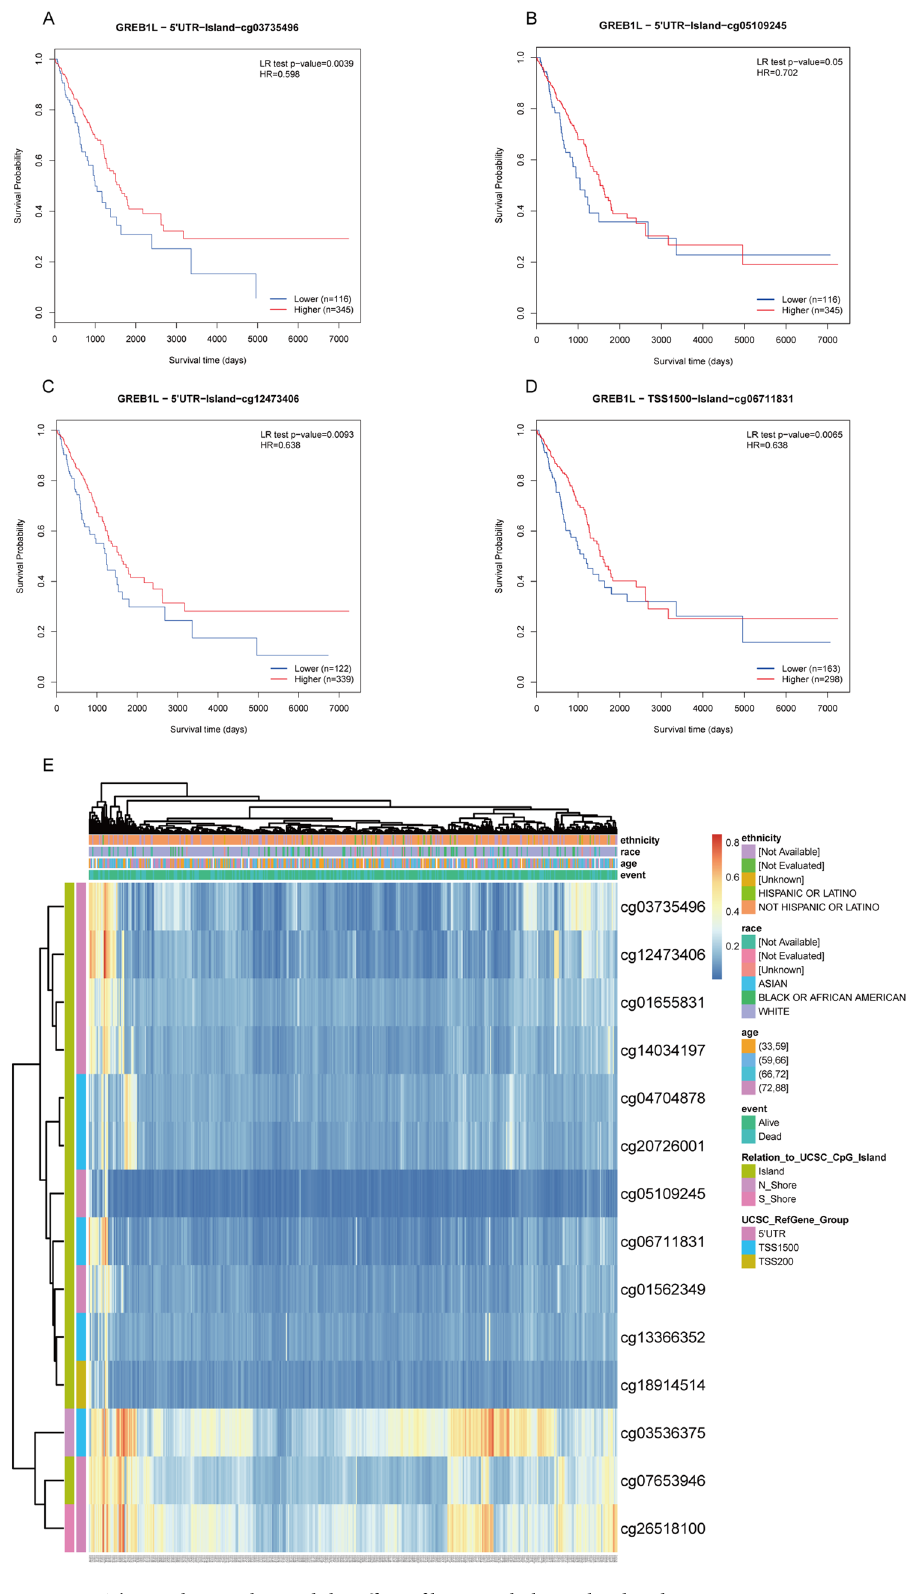
Figure 7. The MethSurv obtained the effect of hypomethylation level and GREB1L expression on prognosis in LUAD. ( A – D ) the Kaplan–Meier survival of the promoter methylation of GREB1L; ( E ) The visualization between the methylation level and the GREB1L expression. (software: MethSurv, version: MethSurv©2017, URL: https:// biit. cs. ut. ee/ meths